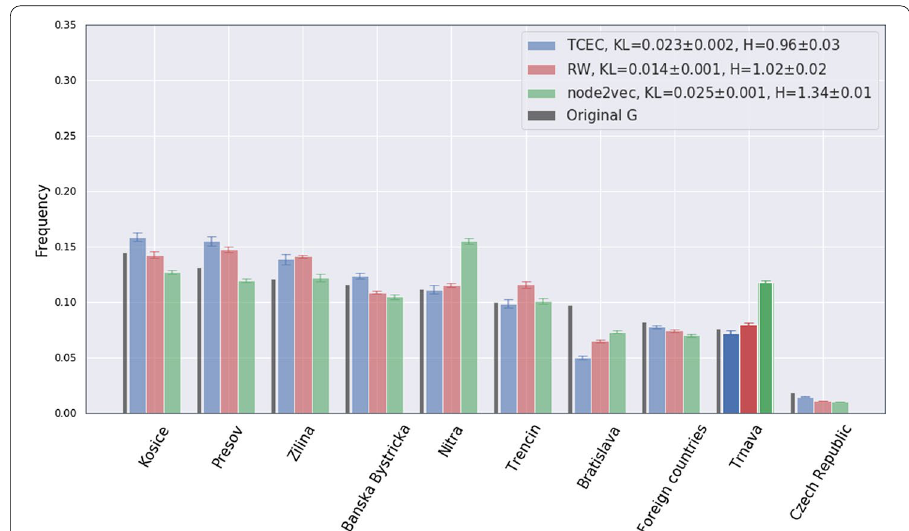
Fig. 5 Covariates distribution and sampling. We consider the Pokec social network dataset ( ≈ 1.3 · 10 6 nodes and ≈ 2.9 · 10 7 edges) with a sample fraction of 10%. The columns with bolded colors represent the region where we started the sampling from. Numbers inside the legend are average and standard deviations over ) , where p G is the empirical frequency of the ten regions in the original graph, similarly 10 runs of KL ( p G || p G m ( s )/ H G ( s ) for p G in the sample. H represents the mean and standard deviation over the same runs for the H G m m entropy ratio. We plot here an example of the relative frequency of nodes for the ten regions in which nodes are divided. The distribution on the whole network is the black vertical line. Vertical lines on top of bars represent standard deviations across 10 runs of sampling. Notice three different behaviors: RW obtains an in-sample attribute distribution similar to the one on the whole graph. TCEC has a higher difference in KL, followed by node2vec. On average, the former two are not biased by the starting region, as it is instead the ( s )/ H G ( s ) case for node2vec. This can also be observed quantitatively by a higher H G m